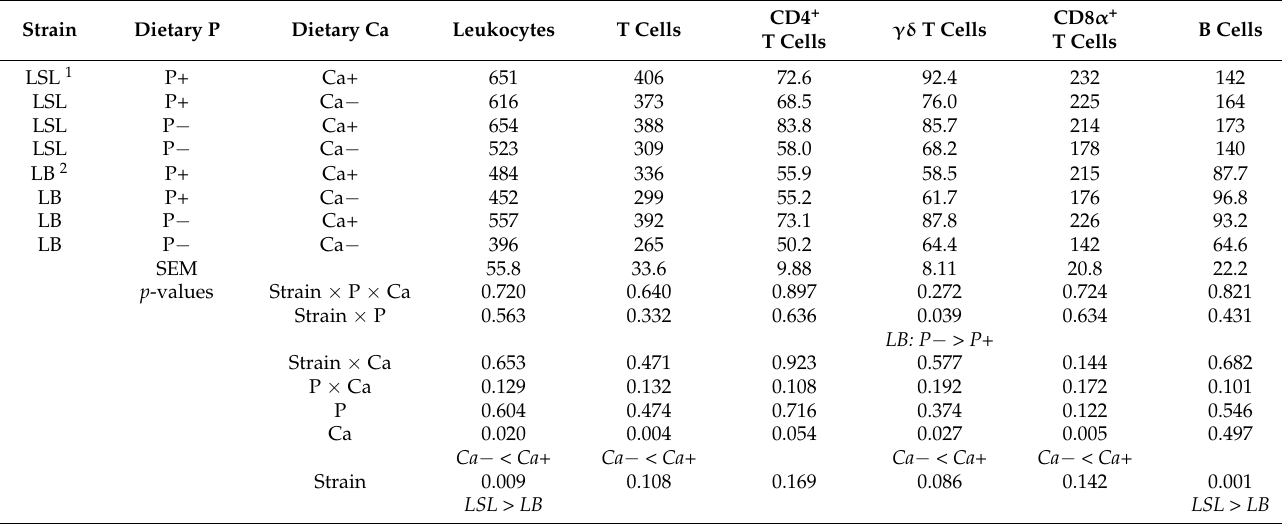
diets had higher concentrations of IgA in bile compared to hens fed P+ or Ca+ diets. IgY and IgM concentrations in plasma did not differ among treatments ( p > 0.05). Table 3. Effect of strain, dietary P and Ca on the number of immune cells ( × 10 5 ) amongst intraepithelial lymphocytes of the cecal tonsils.